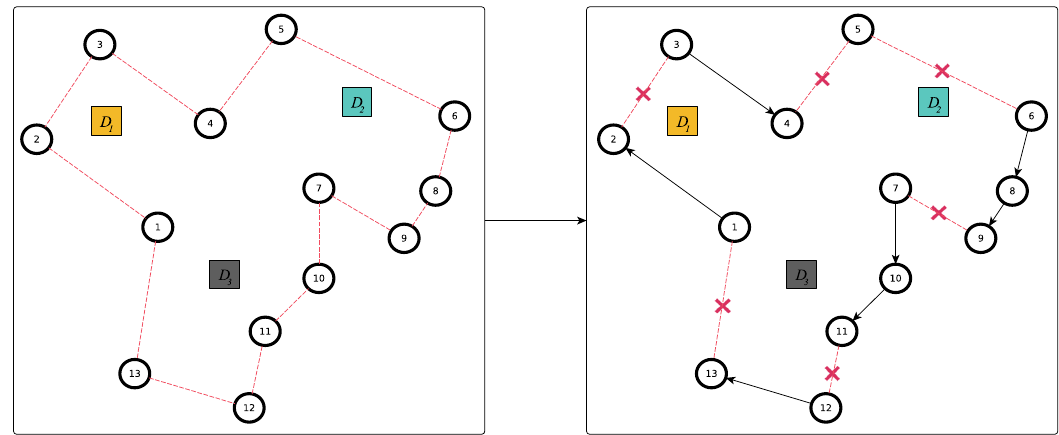
Fig. 5. Sequence generated connecting routes using the nearest neighbor